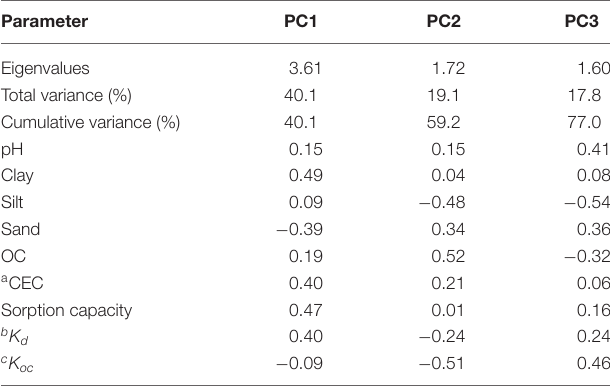
TABLE 3 | Principal component (PC) loadings between selected variables and the first three PCs.